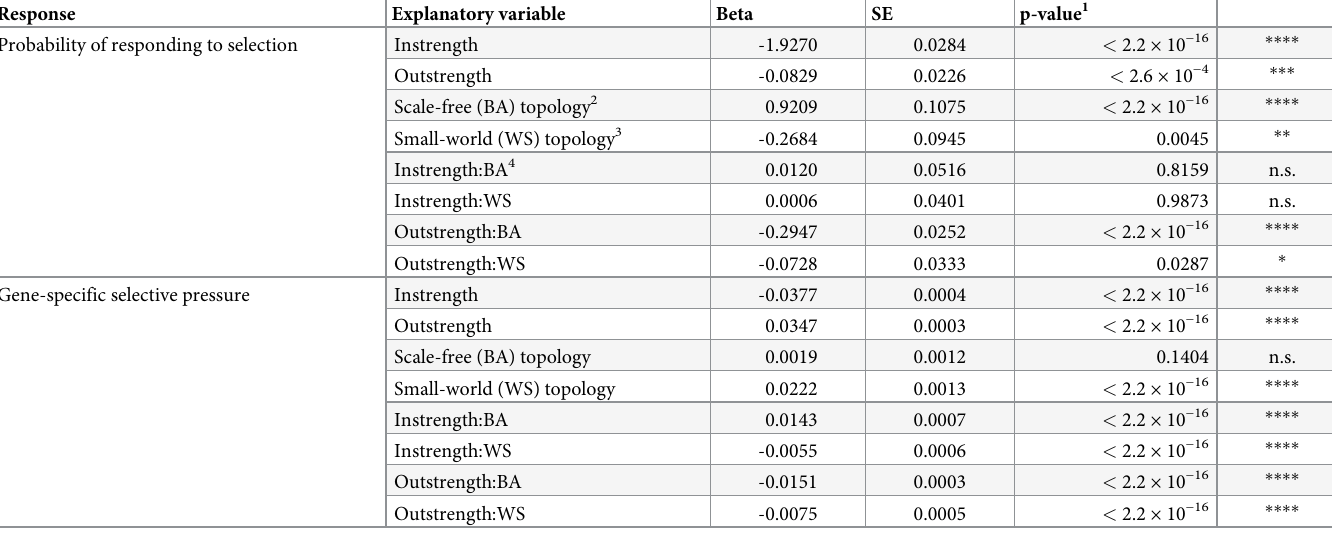
Table 1. Network topology type affects the probability of responding to selection and selective pressure on gene-specific expression noise under stabilizing selection on gene expression level.